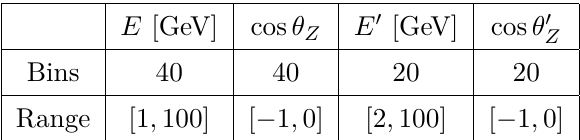
Table 1 . Bin choice for the MC-based response matrix, R , used in this analysis. Energy bins are in log 10